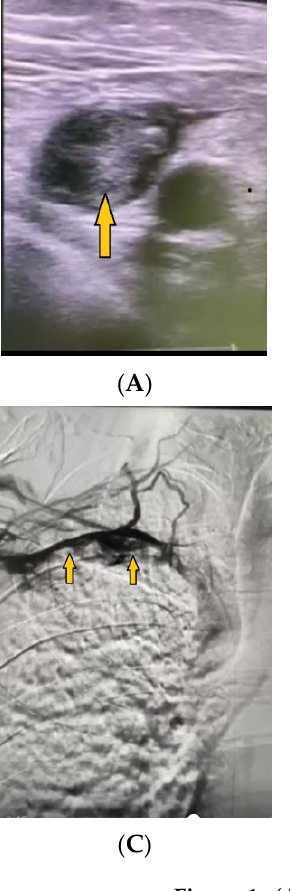
Figure 1. ( A ) Doppler ultrasound revealed subclavian vein thrombosis (yellow arrow). ( B ) Phlebography showed massive thrombotic occlusion of the right subclavian vein (yellow arrows). ( C ) Phlebography revealed subclavian vein thrombosis, mosaic blood flow, and multiple polycyclic shadows (yellow arrows). ( D ) Suprascapular collateral vascular network (yellow arrows).